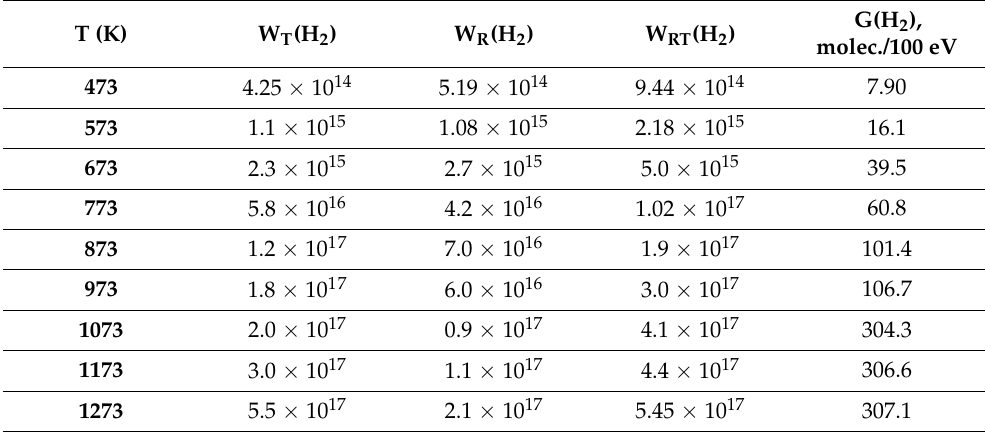
Table 1. The results of thermal, radiation, and radiation–thermal procedures and radiation–chemical yields of hydrogen in seawater decomposition with